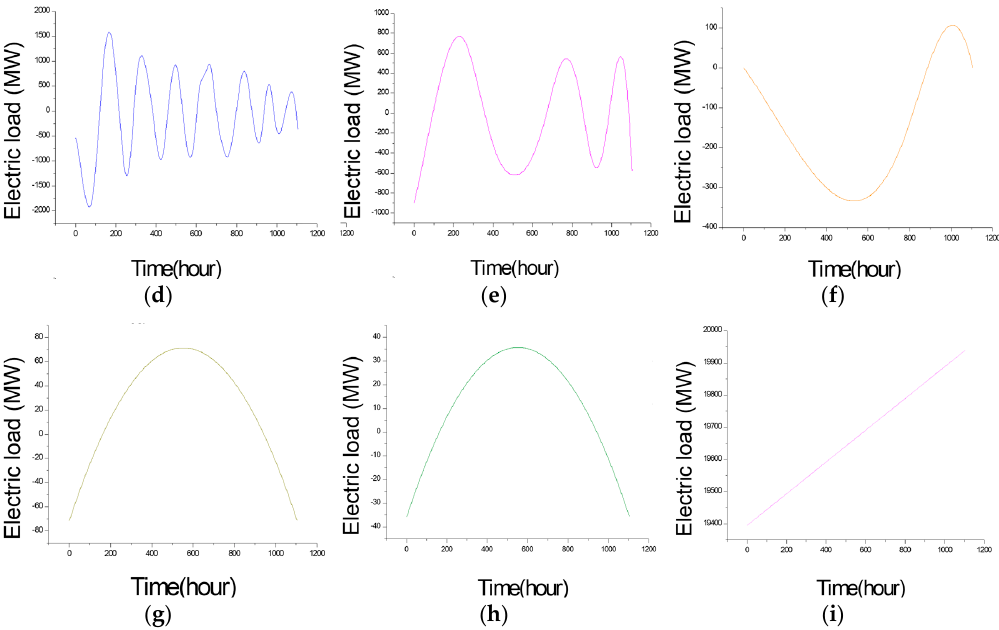
Figure 10. The decomposed different items for the small data size (Example 2). ( a ) IMF (intrinsic